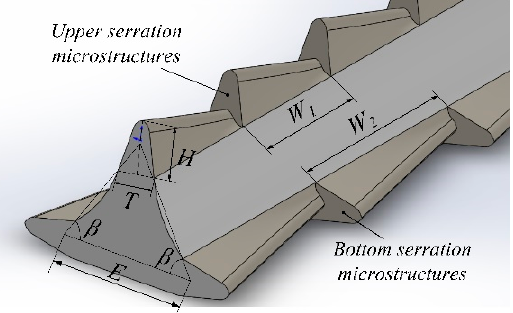
Table 2. Bionic serration microstructure parameters ( μm ).